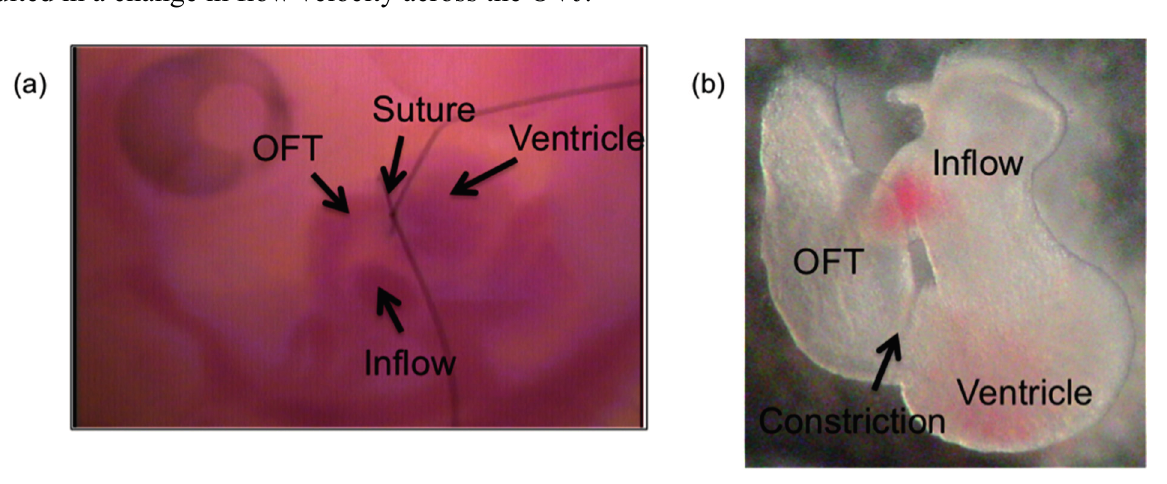
Figure 1. Our in vivo (ex ovo) chicken embryonic system. ( a ) Whole chicken embryo with the outflow tract (OFT) banded, imaged after 24 h; ( b ) isolated chick embryonic heart, 24 h after OFT